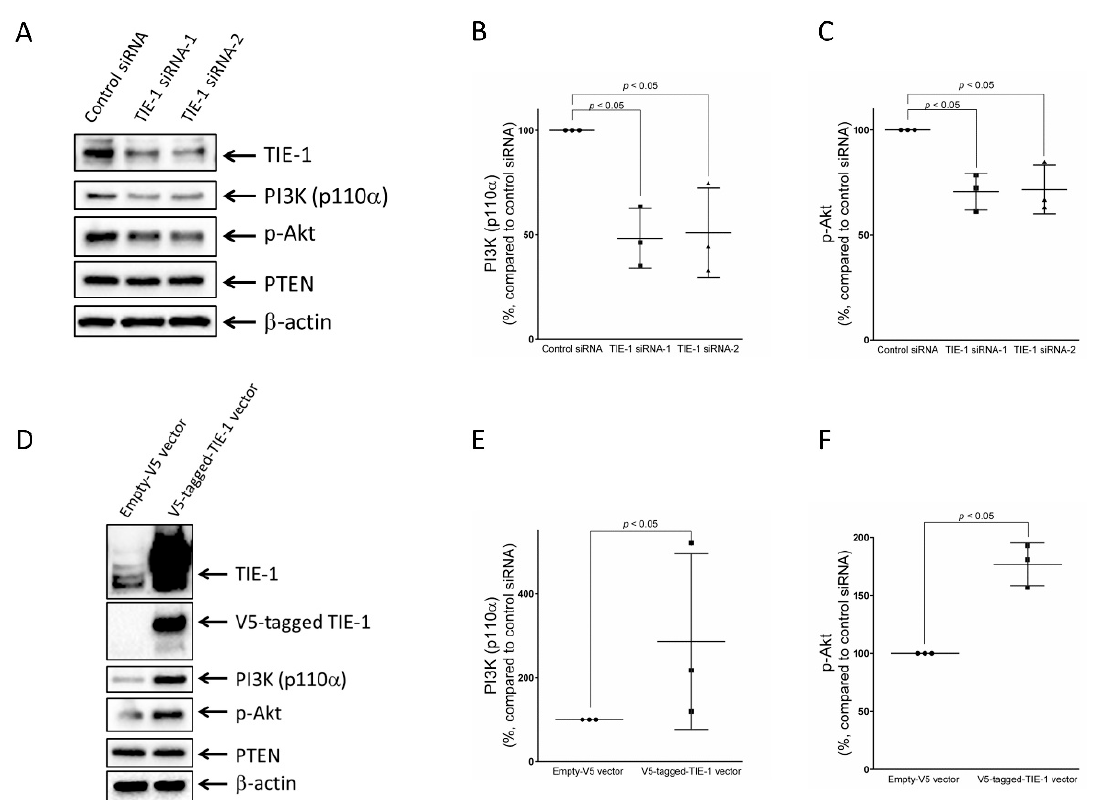
Figure 1. TIE-1 might signal through the PI3K / Akt pathway. ( A ) SKOV3 ovarian-cancer cells were transfected with 5 nM TIE-1 siRNA-1, TIE-1 siRNA-2, or control siRNA, for 72 h. Extracted cellular proteins were subjected to immunoblot analysis with antibodies against TIE-1, PI3K p110 α , phospho-Akt, PTEN, and β -actin. Equal amounts of proteins were loaded in each lane. Three independent experiments were performed, and representative images are shown. Intensity of ( B ) PI3K p110 α and ( C ) phospho-Akt protein expression quantified using Image Lab and shown as mean ± SD of three independent experiments; *, p < 0.05 compared with control siRNA group. ( D ) SKOV3 ovarian-cancer cells transfected with empty vector or V5-tagged TIE-1 vector for 72 h. Extracted cellular proteins subjected to immunoblot analysis with antibodies against TIE-1, V5, PI3K p110 α , phospho-Akt, PTEN, and β -actin. Equal amounts of proteins were loaded in each lane. Three independent experiments were performed, and representative images are shown. Intensity of ( E ) PI3K p110 α and ( F ) phospho-Akt protein expression quantified using Image Lab and shown as mean ± SD of three independent experiments; *, p < 0.05 compared with empty-vector group.